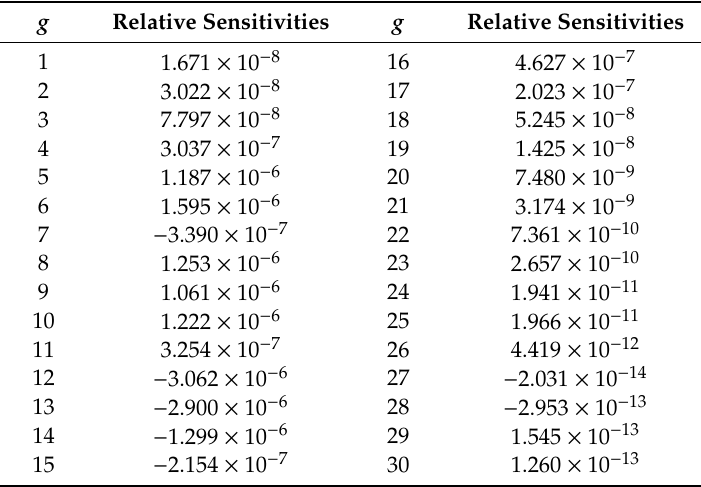
(cid:16) (cid:17) χ g , g = 1, ... i = 2